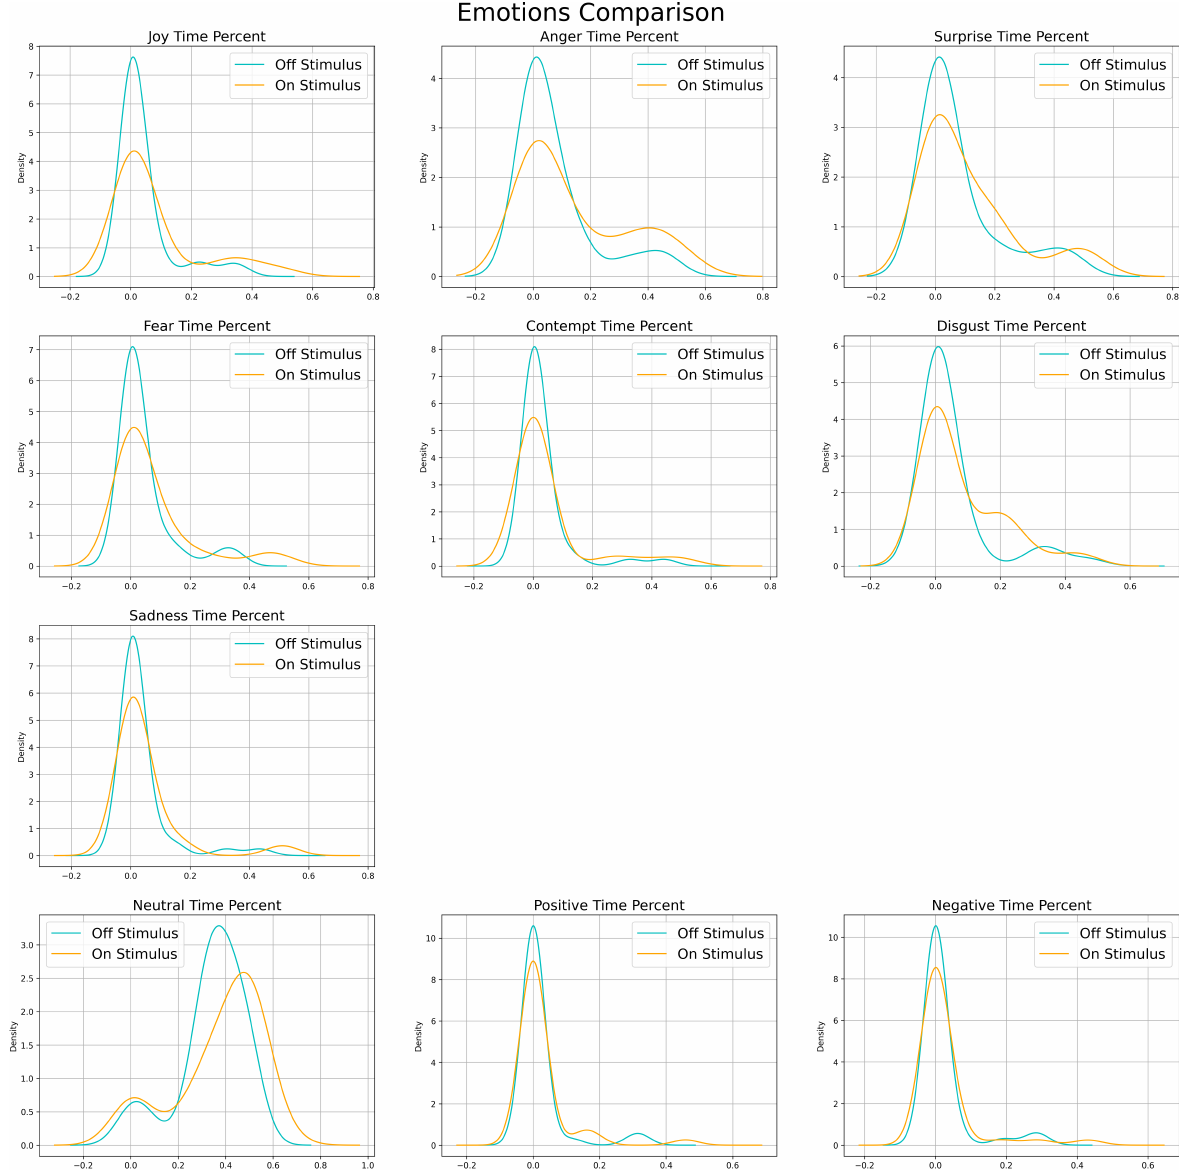
Figure 11. Comparison of the distribution of the percentage of observable time for each emotion between samples of dynamic web design—on-stimulus—and static web